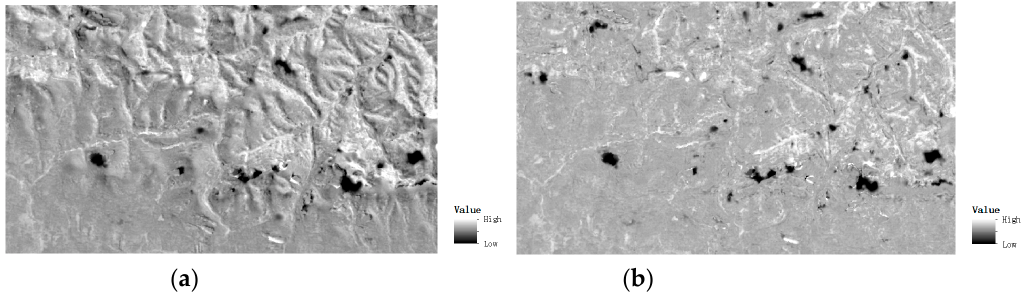
Figure 9. Schematic diagram of comparison between reference DEM and generated DEMs in the Dengfeng mountainous area. ( a ) Elevation difference using the P6; ( b ) Elevation difference using P7.